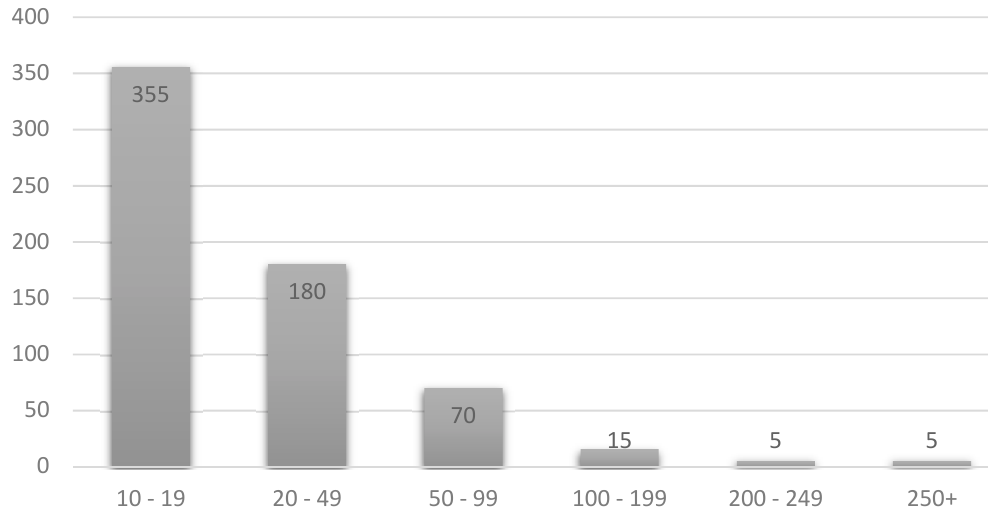
Figure 6. Number of businesses in construction sector in NI, 2022 [46].